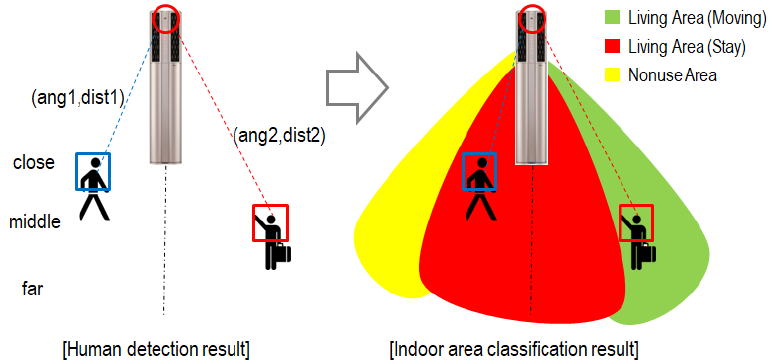
Figure 1. Examples of the Results of Human Body Detection and Indoor Space Area